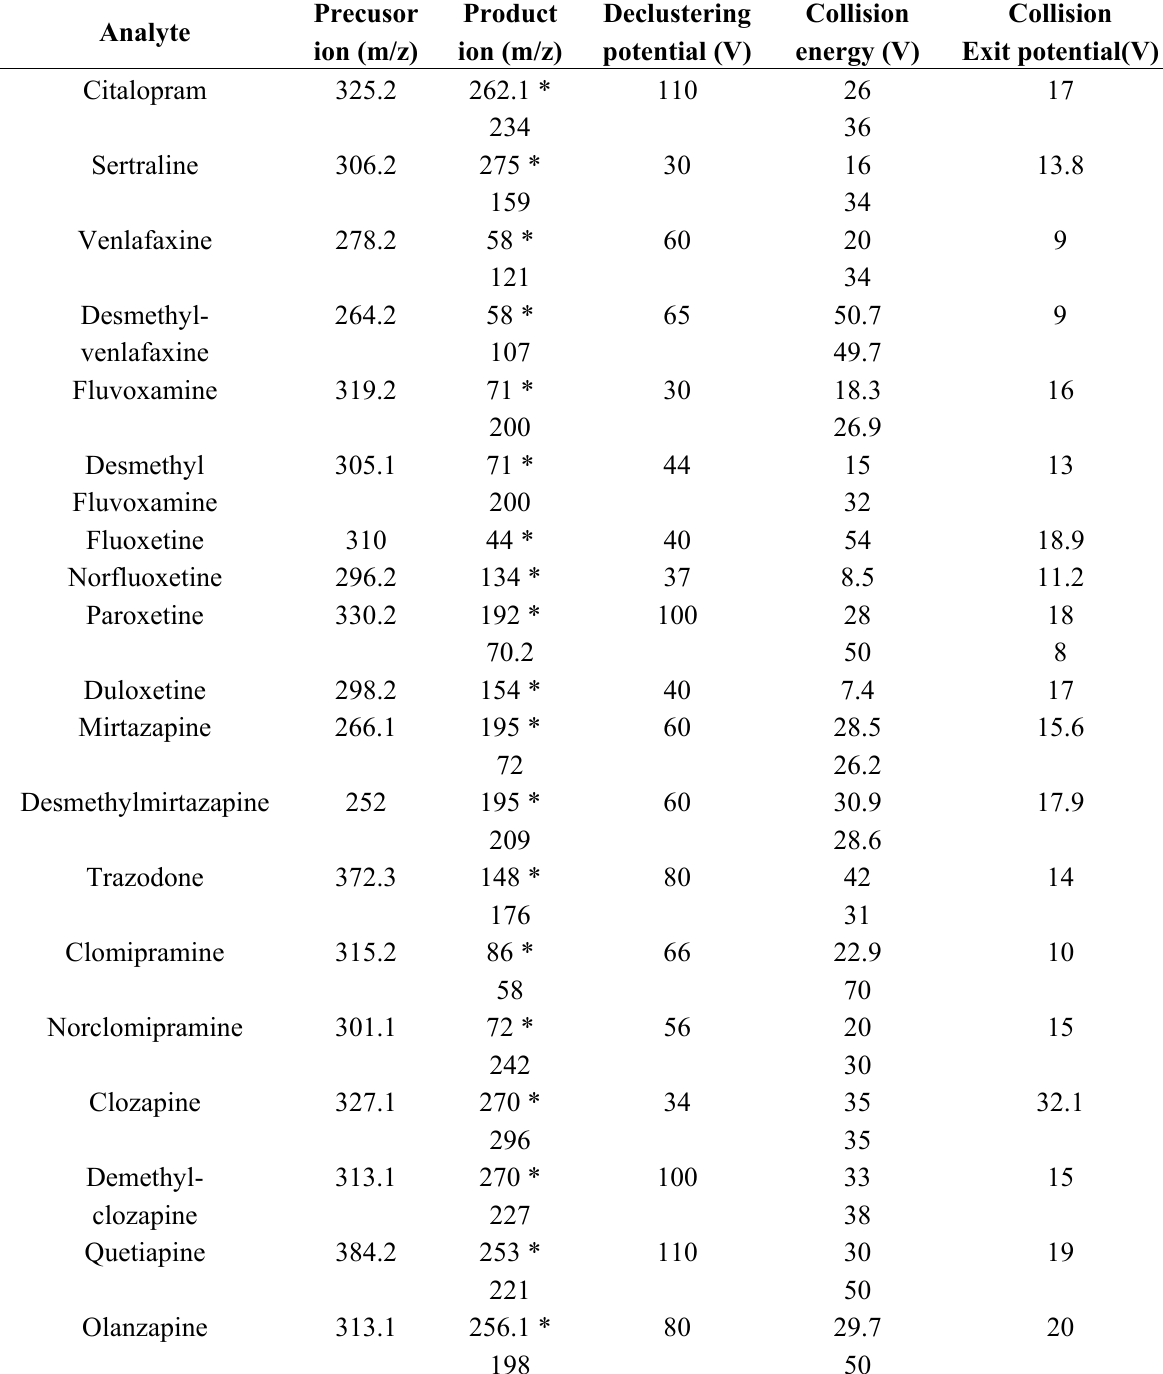
Table 1. Mass spectrometer parameters for each